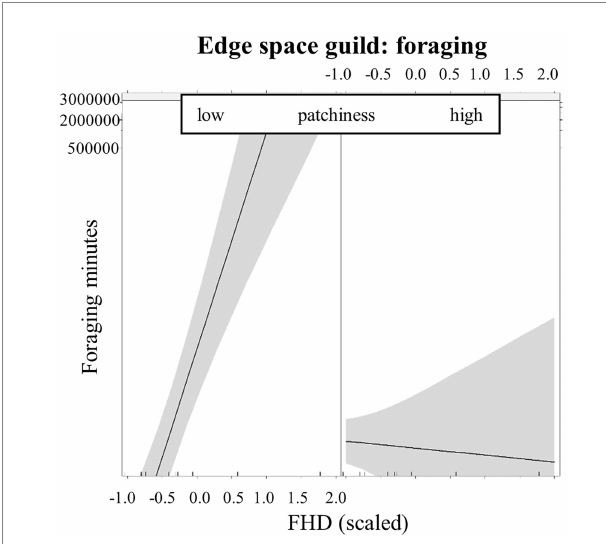
FIGURE 5 Effect plots of the interaction of the foliage height diversity (FHD, scaled) and number of patches (scaled). Boxes show the predicted effects of FHD in low and high amount of number of patches for foraging activity of the edge space guild. Low and high values are represented by the first and third quartile of the number of patches (scaled)